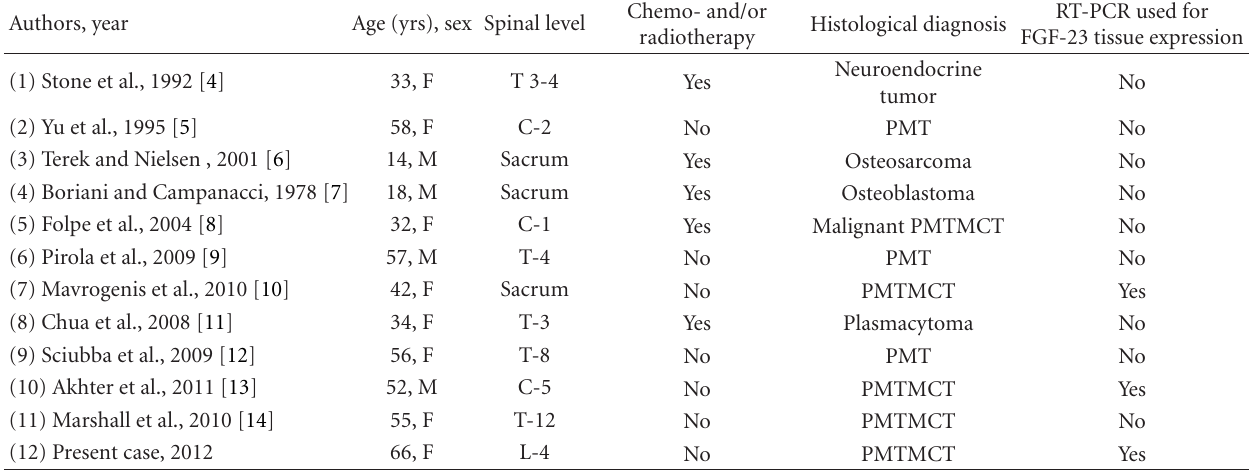
Table 1: Characteristics of spinal cases of TIO.